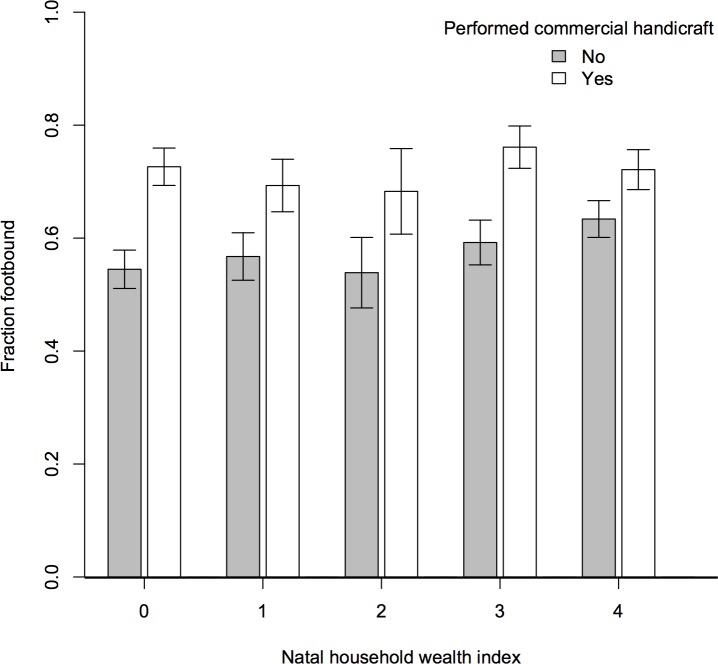
Fraction of women born 1887–1942 who were footbound in 20 counties in rural China by natal household wealth and commercial handicraft production (n = 5373; error bars indicate the 95% CI).Both natal household wealth and whether a girl performed commercial handicraft labor predicted the likelihood of the girl being footbound (logistic regression, both p < 0.001 when all data were pooled). The wealth index was scored as 2 points for family ownership of land, and 1 point each for ownership of a house or draft animal ([18], Appendix B).